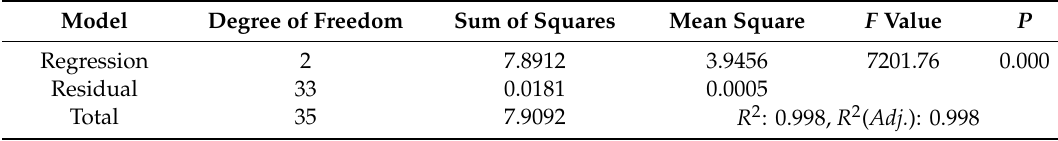
Table 5. ANOVA of the regression model for S ba.